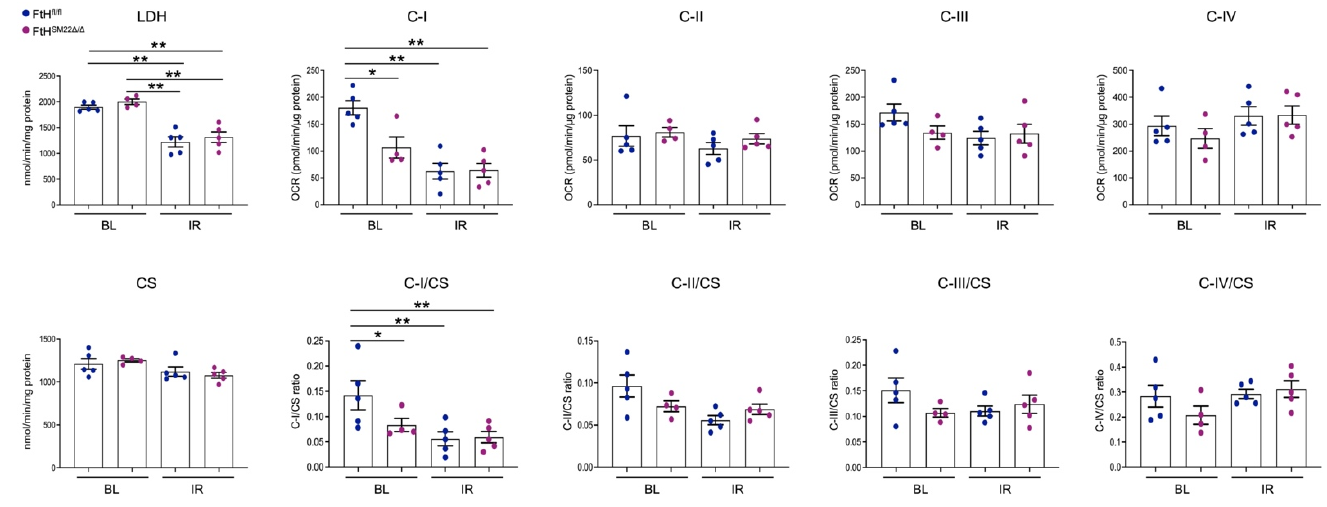
Figure 3. Evaluation of mitochondrial complex, lactate dehydrogenase (LDH), and citrate synthase (CS) activity in frozen heart lysates from BL and IR conditions in FtH fl/fl and FtH SM22 ∆ / ∆ mice. Protein was isolated from the left ventricle under BL conditions and the ischemic region at 3 h following IR from FtH fl/fl and FtH SM22 Δ / Δ frozen hearts. Mitochondrial complex activity including NADH (complex I), succinate (complex II), duroquinol (complex III), or tetamethylphenylenediamine (complex IV) was measured in heart lysates from BL and IR conditions in FtH fl/fl and FtH SM22 Δ / Δ mice and oxygen consumption rate (OCR) was expressed as pmol/min/ μ g protein. LDH and CS activities are ex- pressed as nmol/min/mg protein. Graphs depict cumulative quantification of data; n = 4–5. Data are presented as means ± SEM. * p < 0.05 and ** p < 0.01.